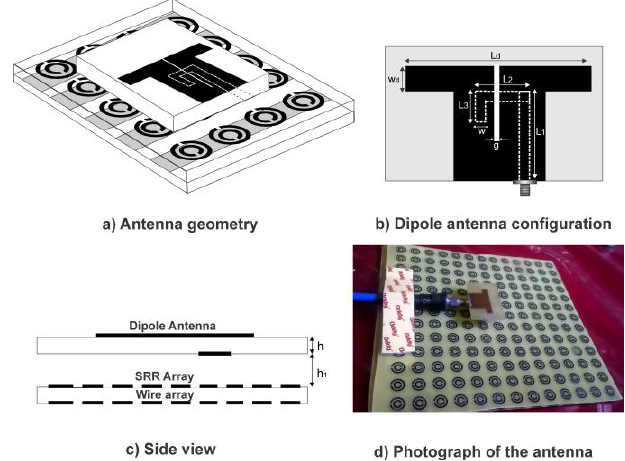
Figure 4: Geometry of the Metamaterial backed dipole antenna